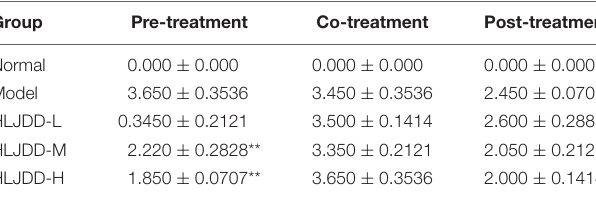
TABLE 4 | Overall histological score of jejunum of CPT-11-treated mice.